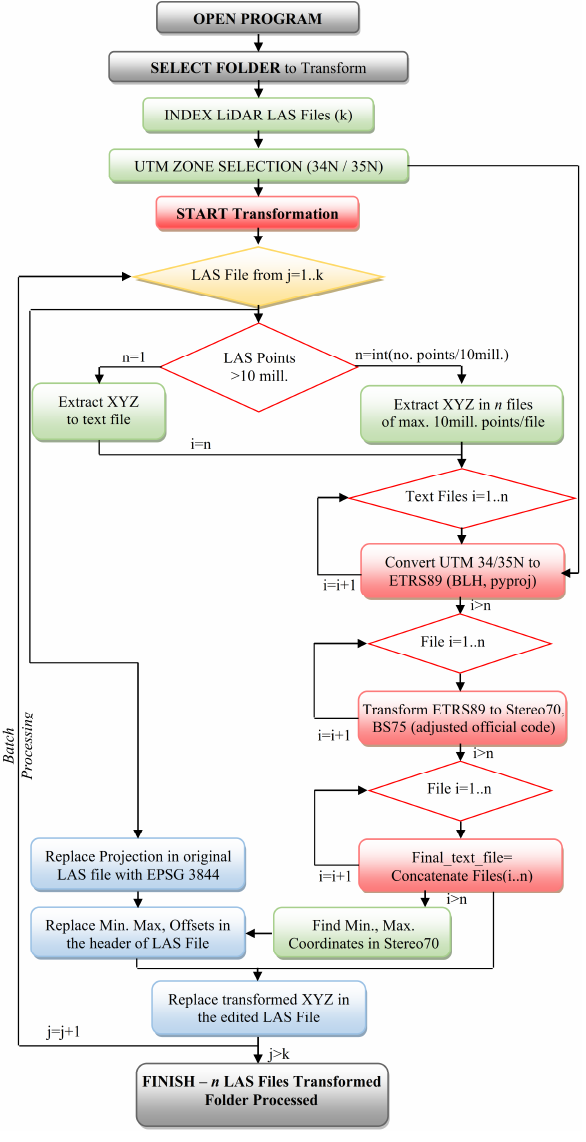
Figure 1 . Logical scheme of the transforming